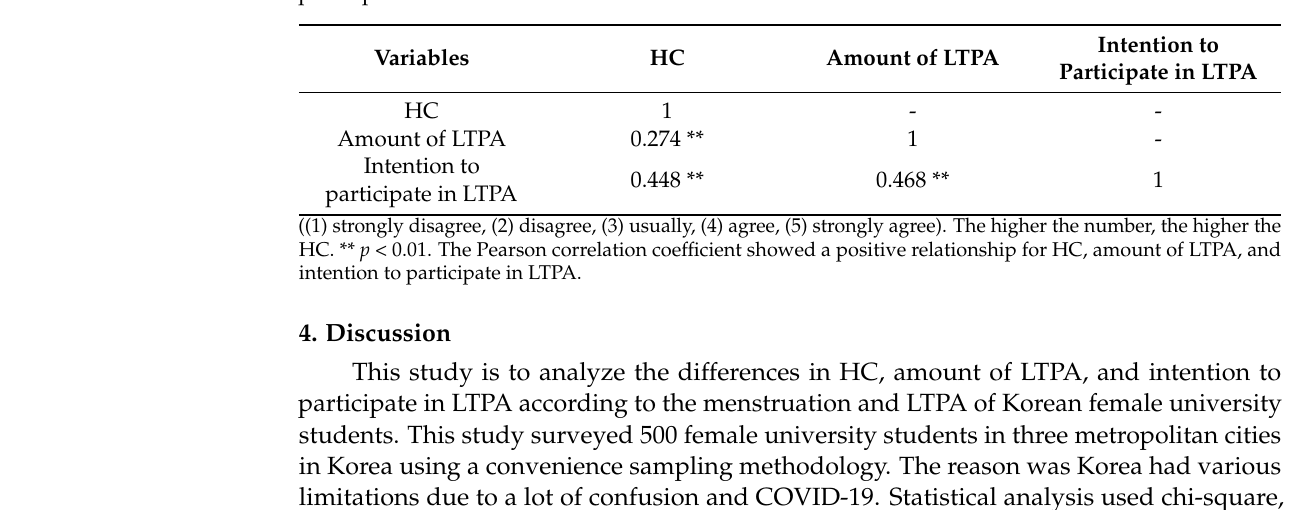
Table 7. Pearson’s correlation coefficient analysis among HC, amount of LTPA, and intention to participate in